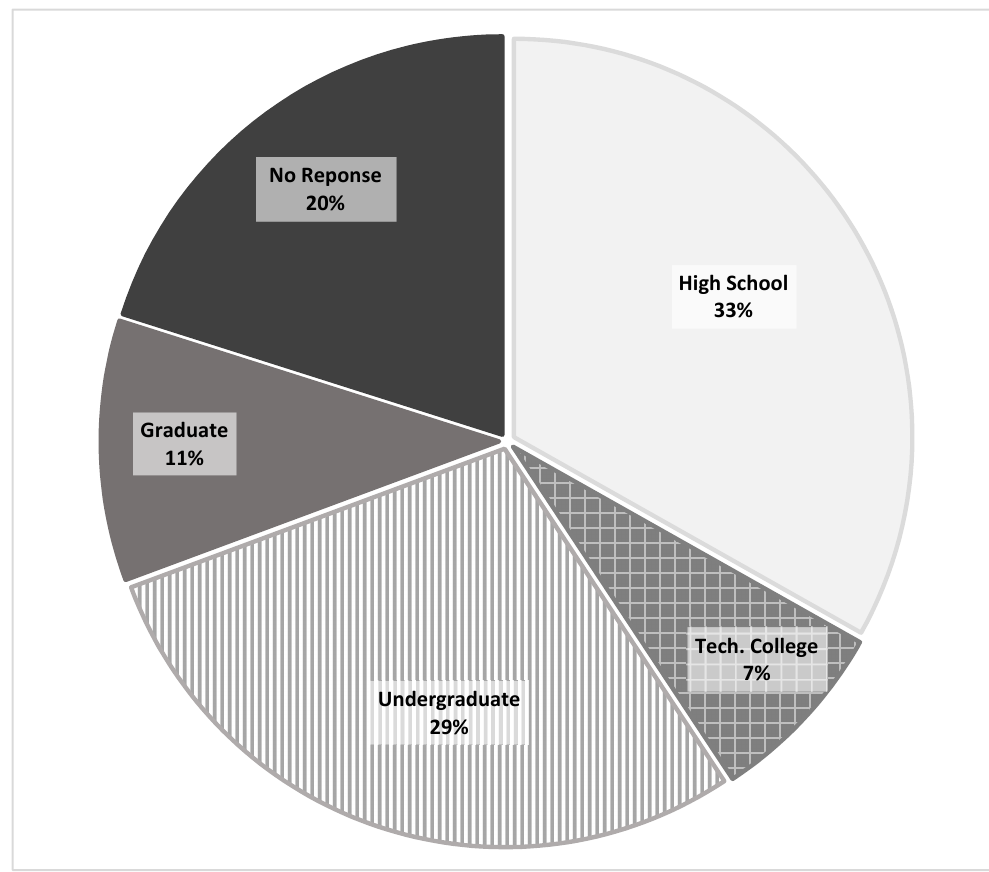
Figure 3. Educational aspirations of youth across workshop locations.